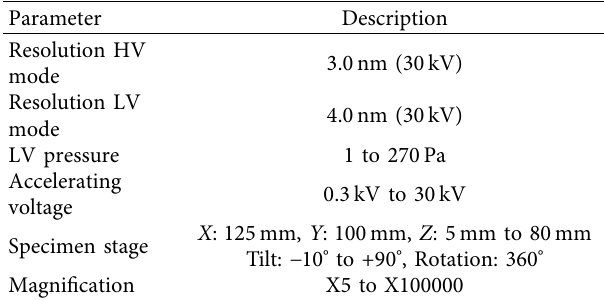
Table 3: Specifications of